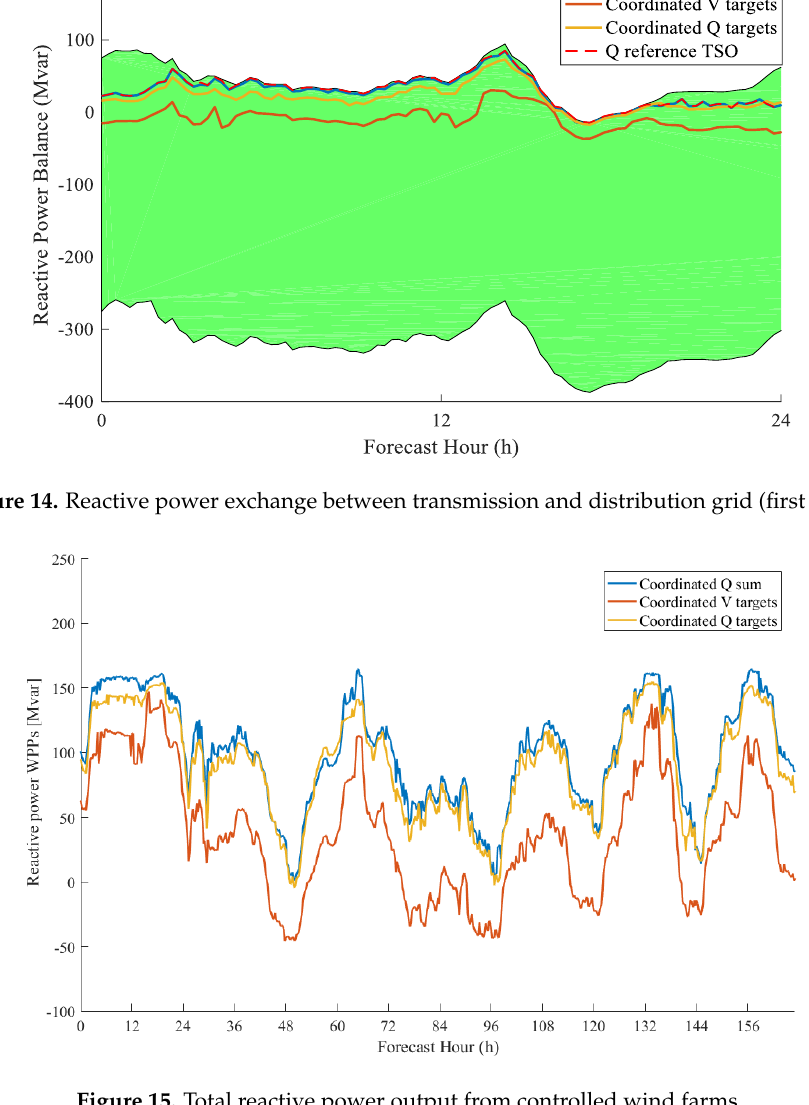
Figure 15. Total reactive power output from controlled wind farms.